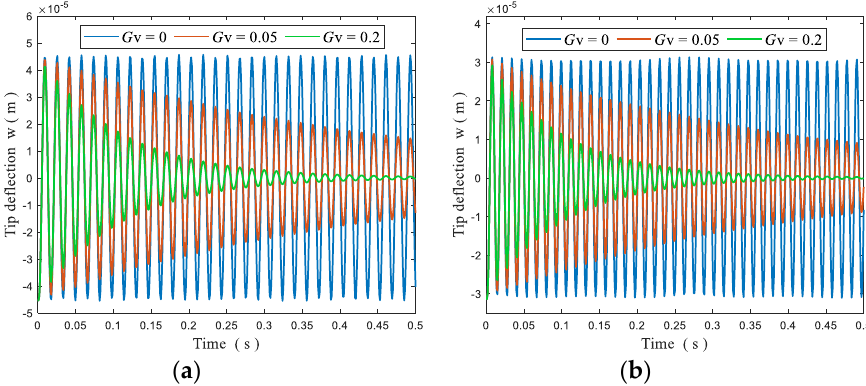
Figure 17. The tip transient deflection of a CFFF PFGP under an initial uniformly distributed load of